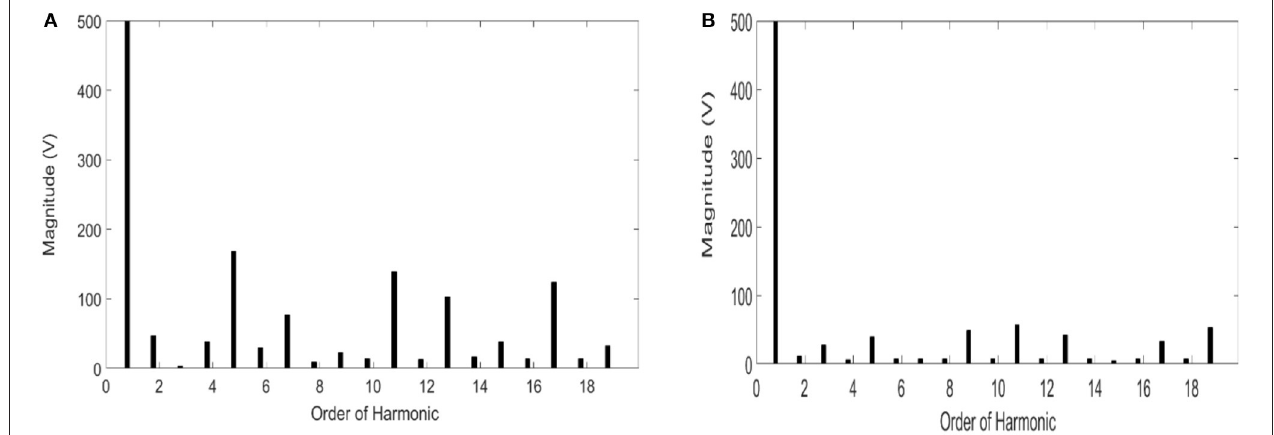
FIGURE 11 | Harmonic spectrum before and after the activation of harmonics control. (A) Harmonic spectrum before activation of harmonics loop. (B) Harmonic spectrum after activation of harmonics loop.